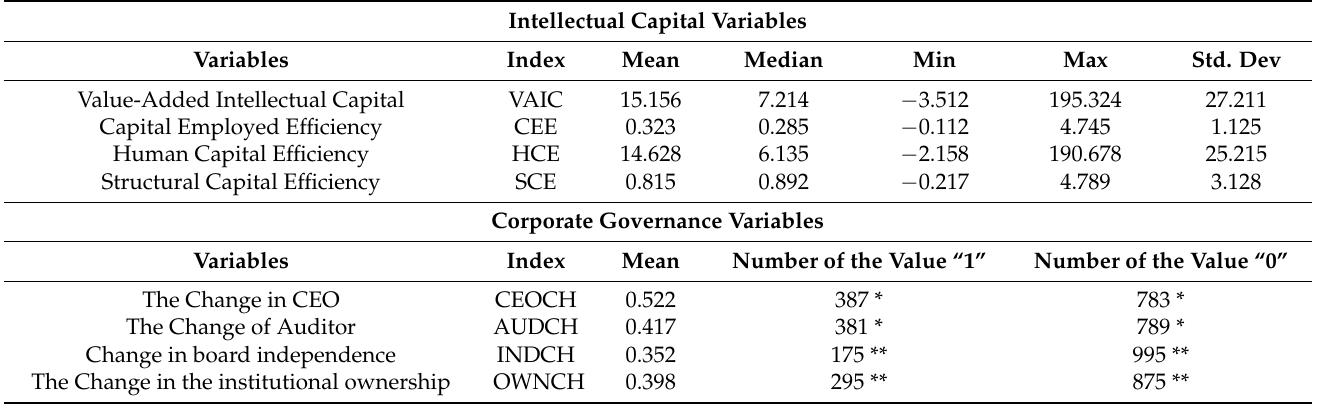
Table 1. Descriptive statistics of the research